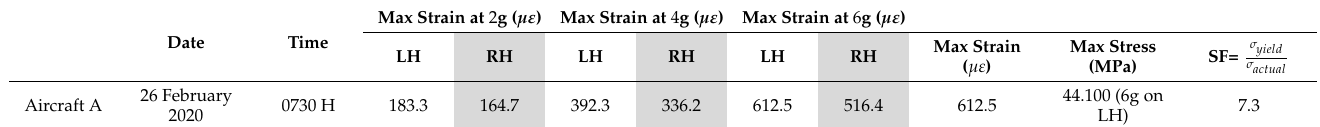
Figure 19. Acceleration data from aircraft flight test. Table 4. Strain and stress